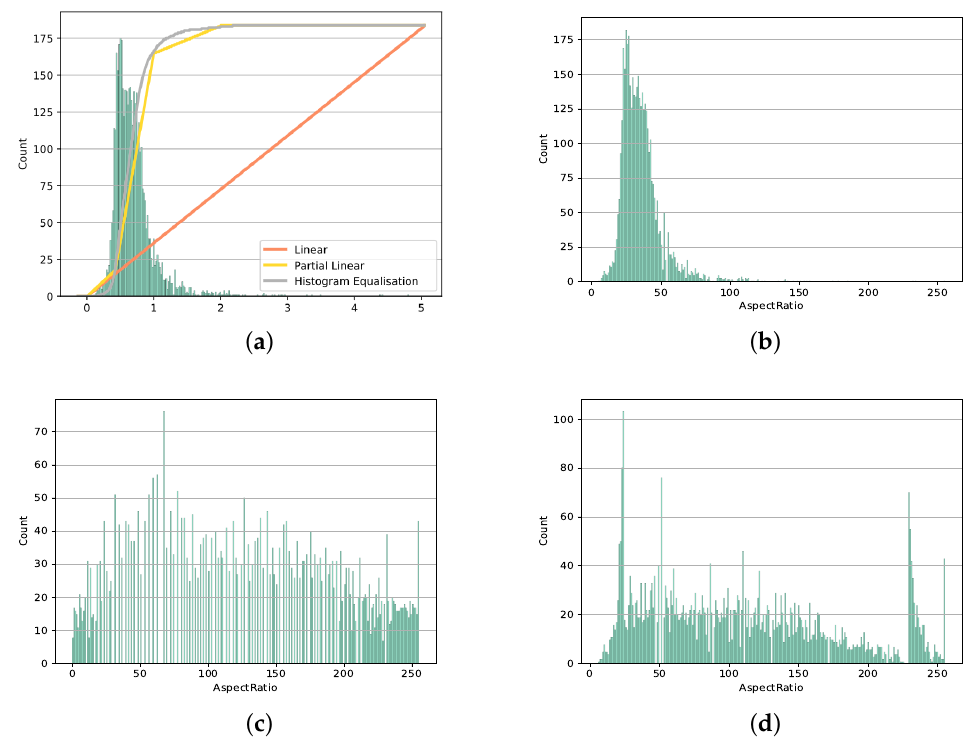
Figure 8. Visualization of the transfer function and the value range before and after mapping at the example for the aspect ratio. ( a ) Original value range and transfer functions ( b ) with linear mapping, ( c ) with histogram equalization, and ( d ) with partial linear mapping. Table 5. F1 score results of the test series with contour properties. Linear Part. Linear Hist.